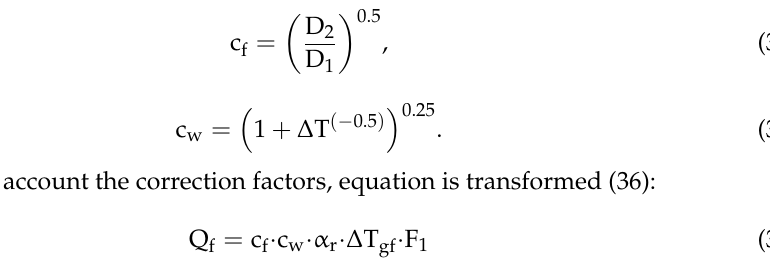
Table 6. Dependency of the coefficient c w on the temperatures of cold and heated air for a coil-type steam boiler. With the Coldest At the Average Temperature Five Days, ◦ C of the Coldest Month, ◦ C